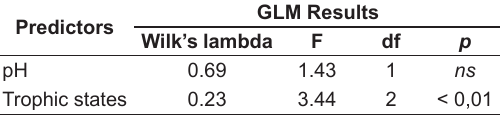
Table 4. Results of Generalized Linear Models (GLMs) testing the effects of pH and trophic states on the total density of five zooplankton taxa ( Moina minuta , Latonopsis sp., Brachionus urceolaris , Hexarthra mira and Thermocyclops sp.) pooled